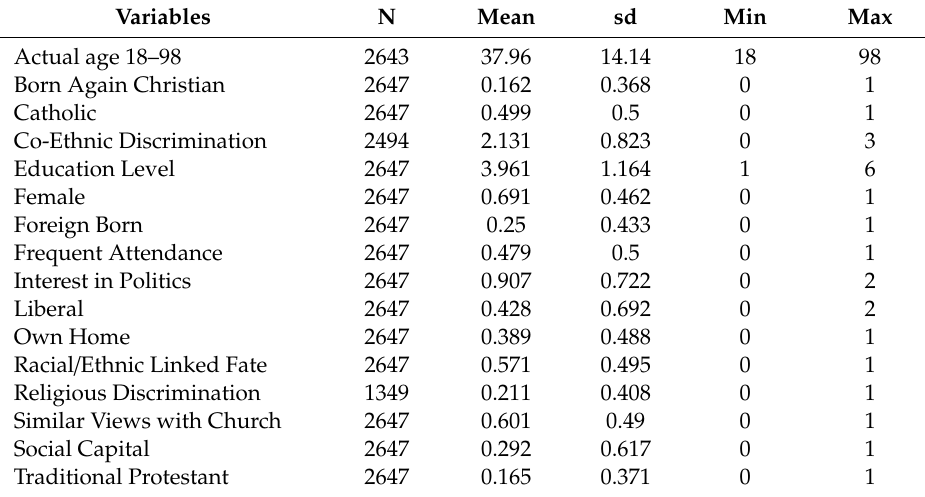
Table 3. Latino respondents’ summary